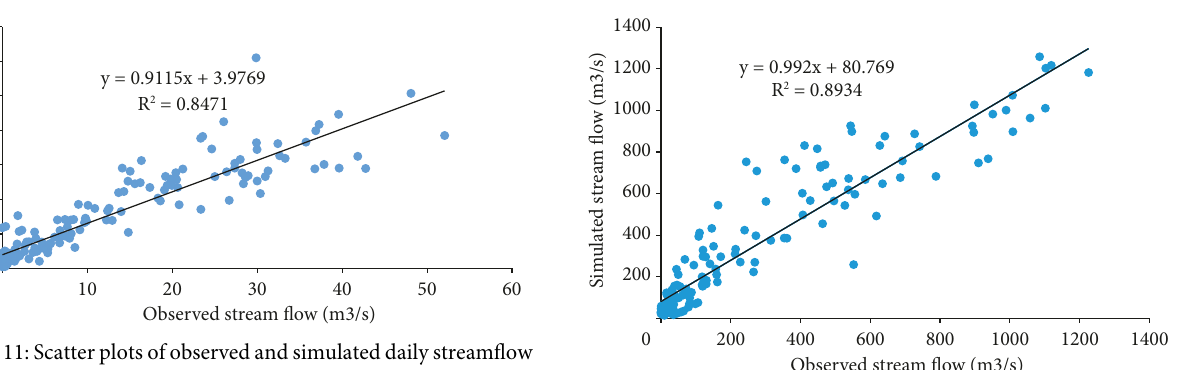
Figure 10: Monthly streamflow of the Nashe watershed in calibration and validation periods. (a) Observed and simulated. (b) 95PPU plot.